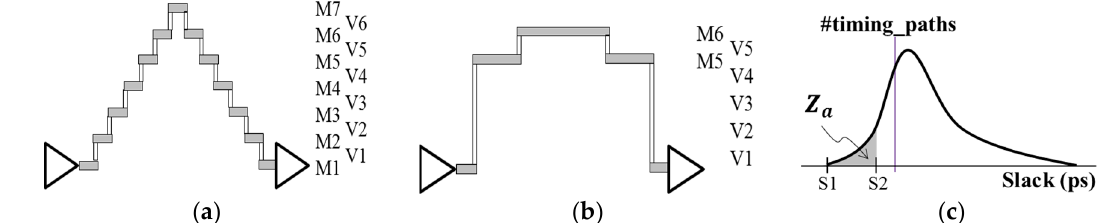
Figure 4. Routing structures for ( a ) typical nets on all metal layers and ( b ) timing-critical nets on the optimal AG layers. ( c ) Critical-path zone, Z a , on the slack distribution graph for applying AG-aware routing.